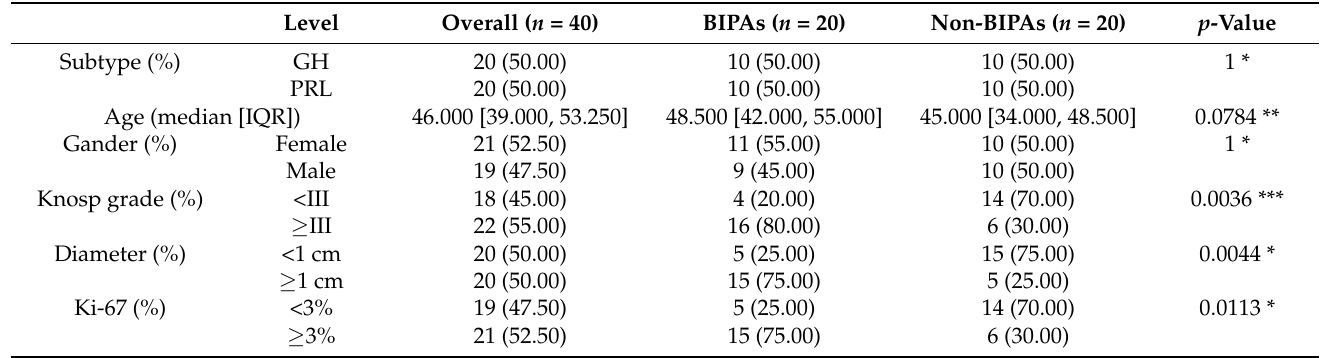
Table 1. Summary of clinical patient features on BIPAs versus